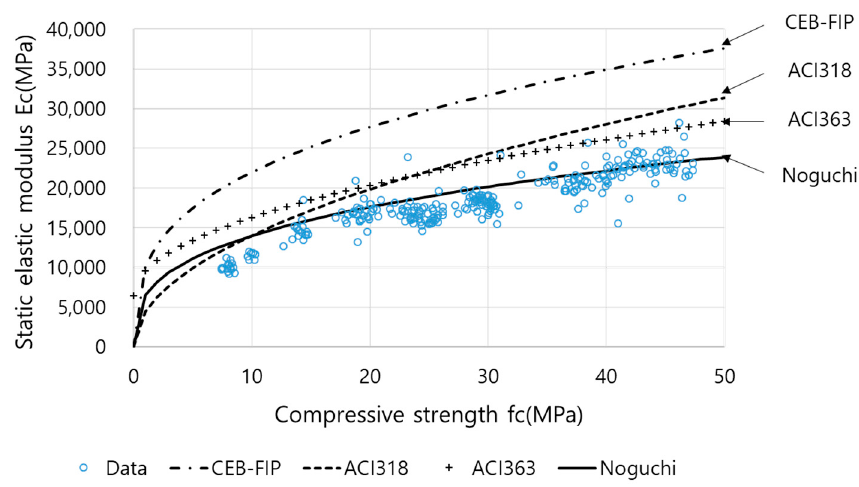
Figure 12. Comparison of the relationships between Ec and fc .